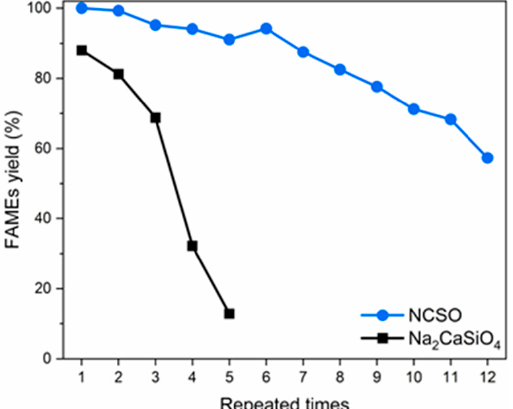
Figure 4. Reusability of the NCSO catalyst. Reaction conditions: molar ratio of methanol to oil = 9:1, agitation speed = 400 rpm, 9 wt.% catalyst loading, 80 °C, 60 min.